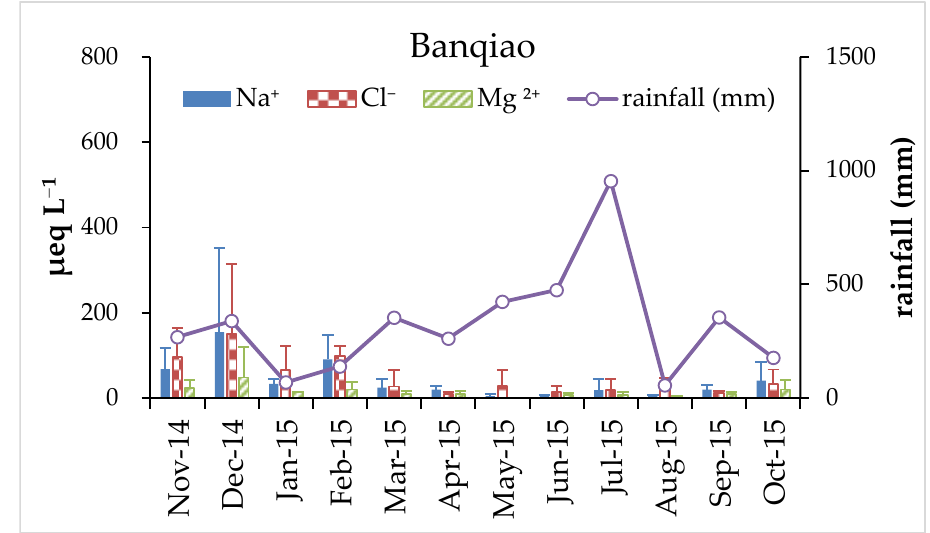
Figure 4. Variations in the monthly average concentrations of sea-salt ions at Wanli and Banqiao. (error bars represent the standard deviations for each month).